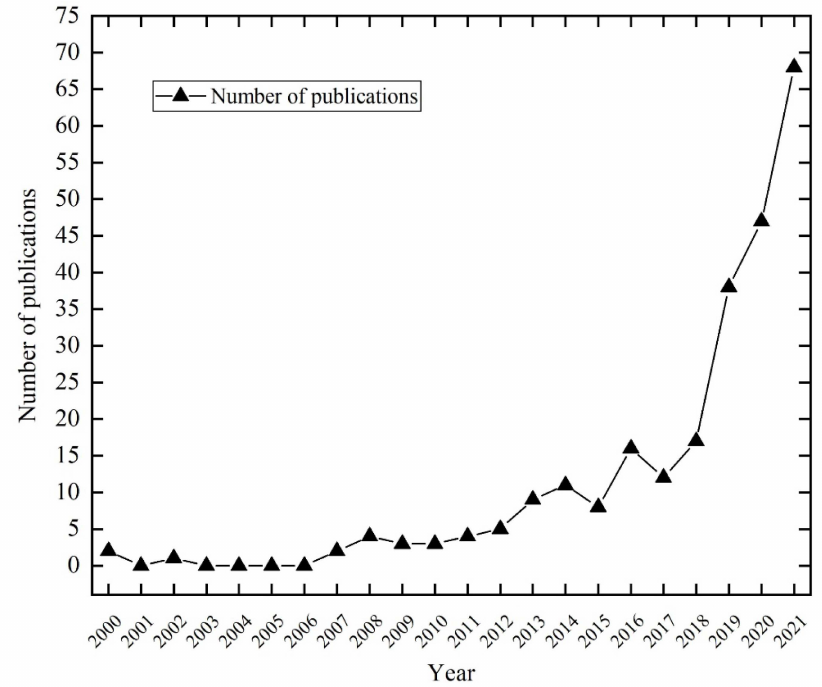
Figure 1. Trends in the number of publications during